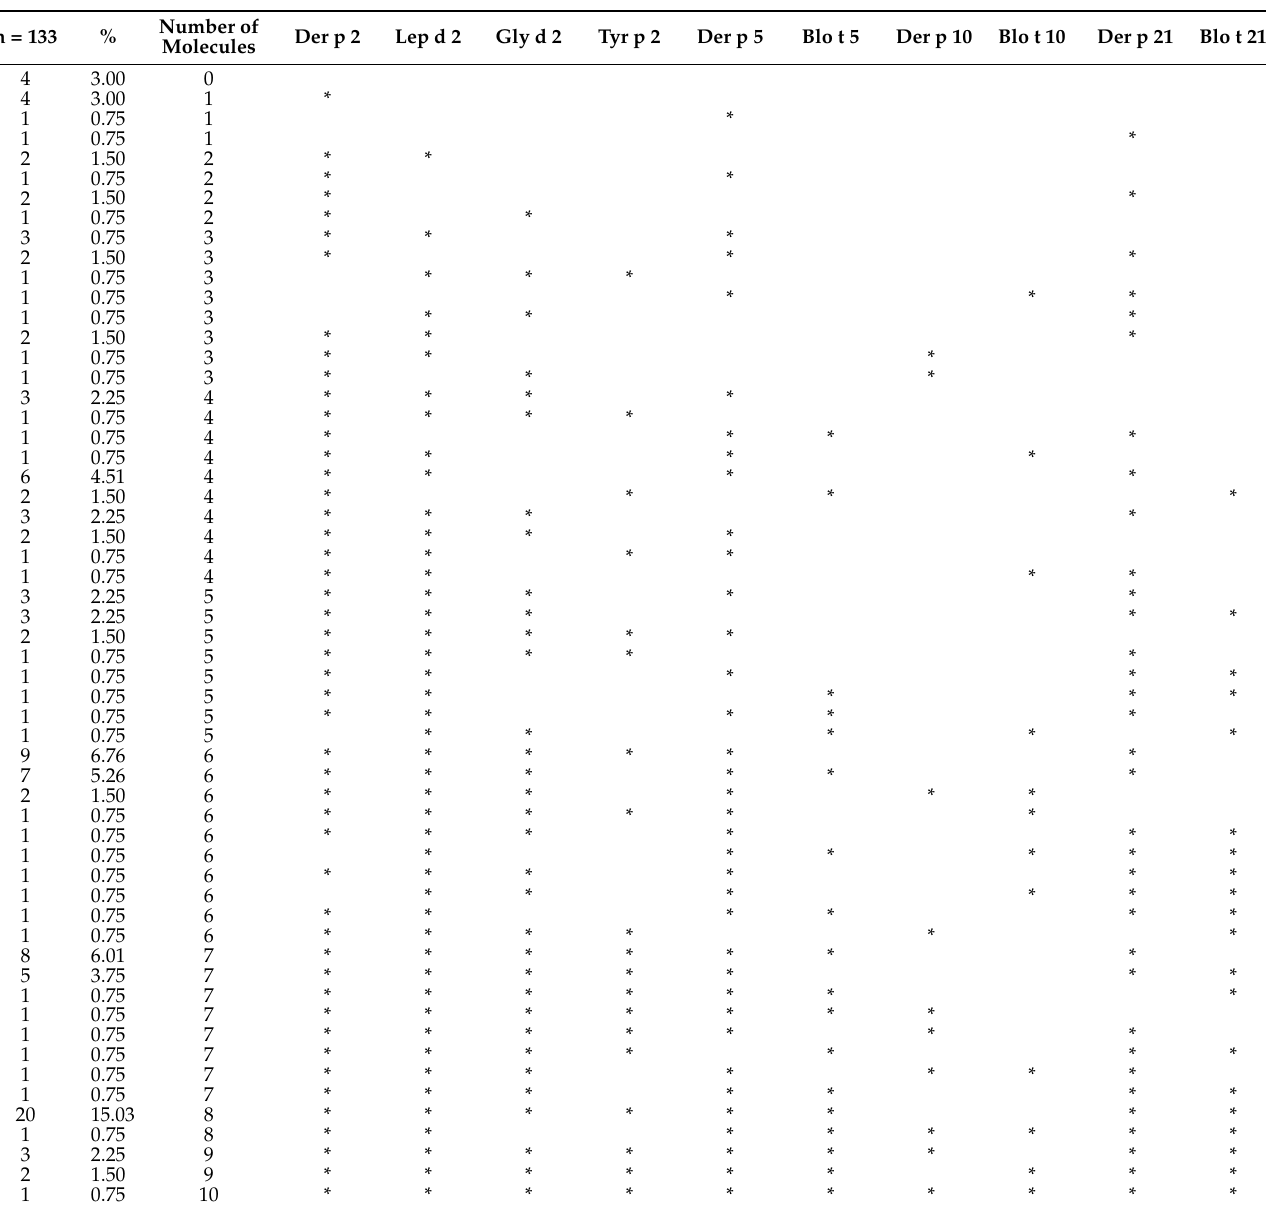
Table 3. Specific IgE profiles aggregated into mite homologous group allergens 2, 5, 10 and 21 between D. pteronyssinus and storage mites in 133 subjects tested with microarray. Profiles are ordered by the increasing number of recognized